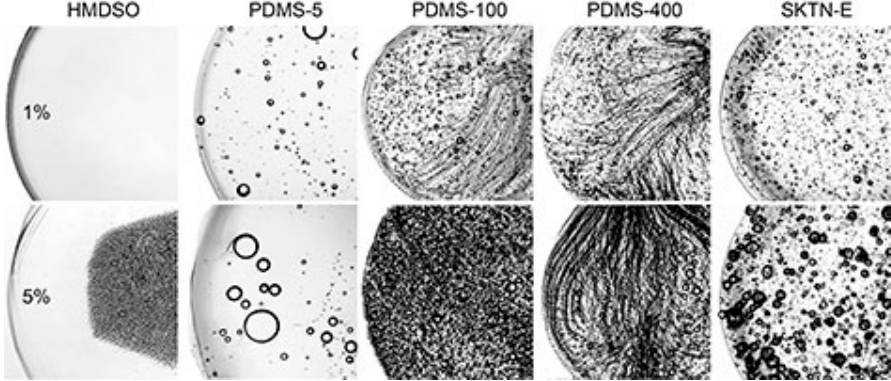
Figure 12. The morphology of heterophase droplets of compositions based on PAN solutions, containing 1% and 5% of HMDSO, PDMS-100, PDMS-400, and SKTN-E after the coagulation process.